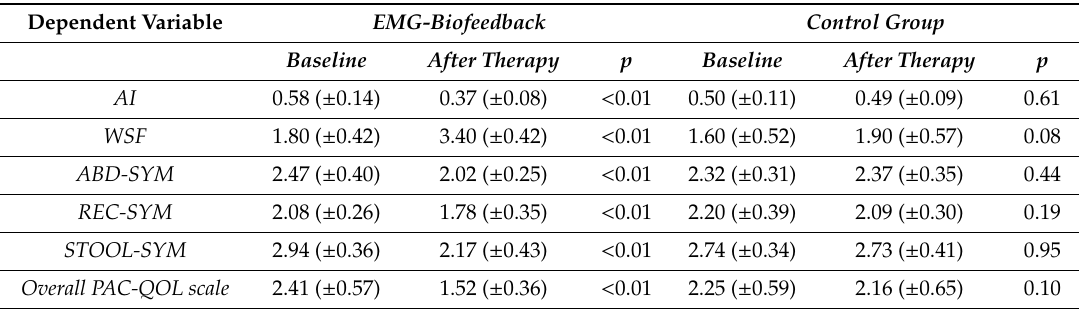
Table 1. Anismus index, weekly stool frequency, clinical symptoms, and overall quality of life (QOL) measure before and after treatment in the electromyographic biofeedback (EMG-biofeedback) group and control group.